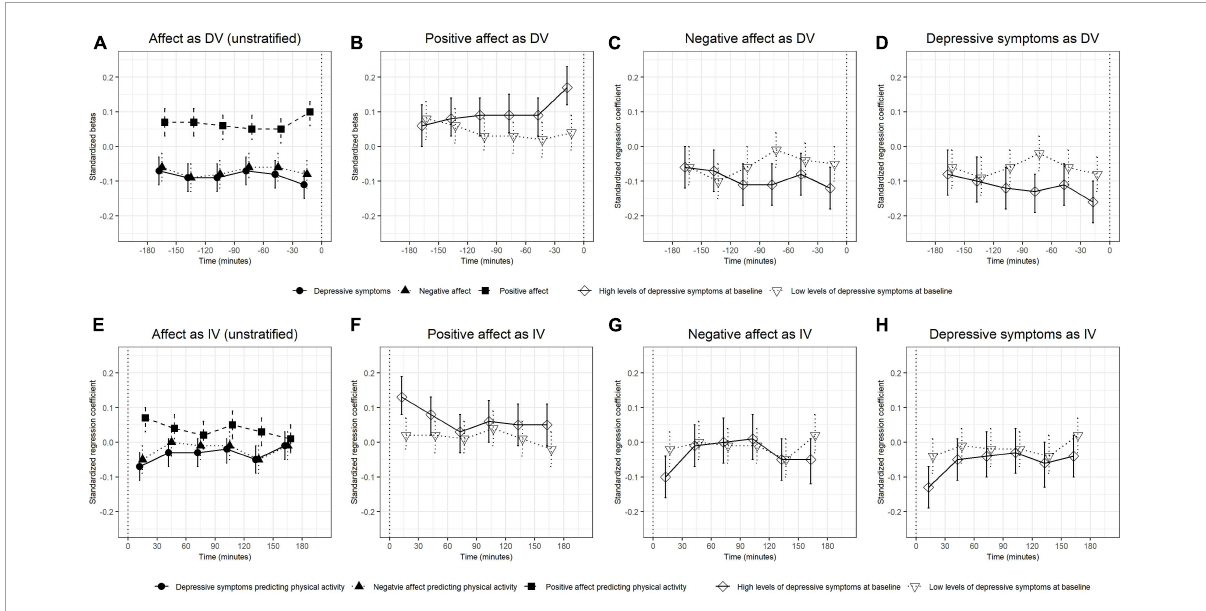
FIGURE1 The standardized betas and confidence intervals of multilevel models in which physical activity predicted the subsequently measured dependent variables (DVs) positive affect, negative affect, and depressive symptoms (A–D) and models in which the independent variables (IVs) positive affect, negative affect, and depressive symptoms predicted subsequent physical activity (E–H) . Results for all participants (unstratified) (A,E) . Results for positive affect (B,F) , negative affect (C,G) , and depressive symptoms (D,H) are stratified by baseline levels of depressive symptoms.